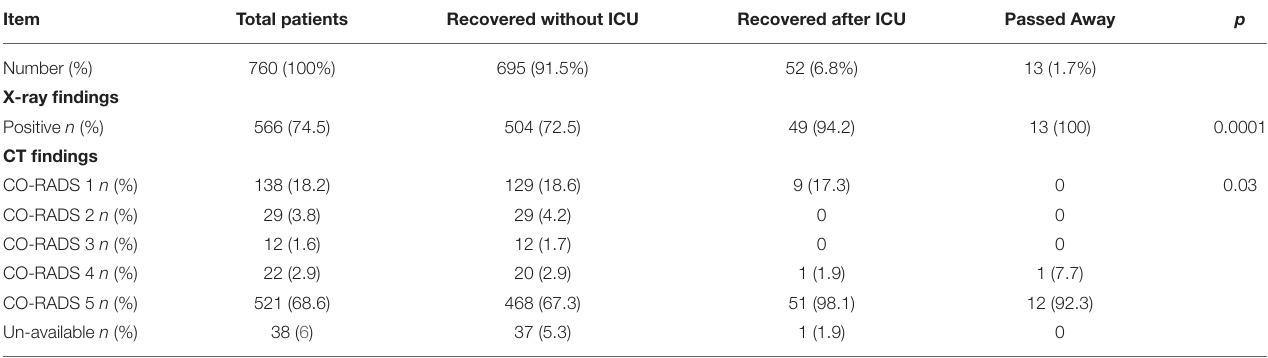
TABLE 4 | Radiological characteristics of the studied groups of patients. Item Total